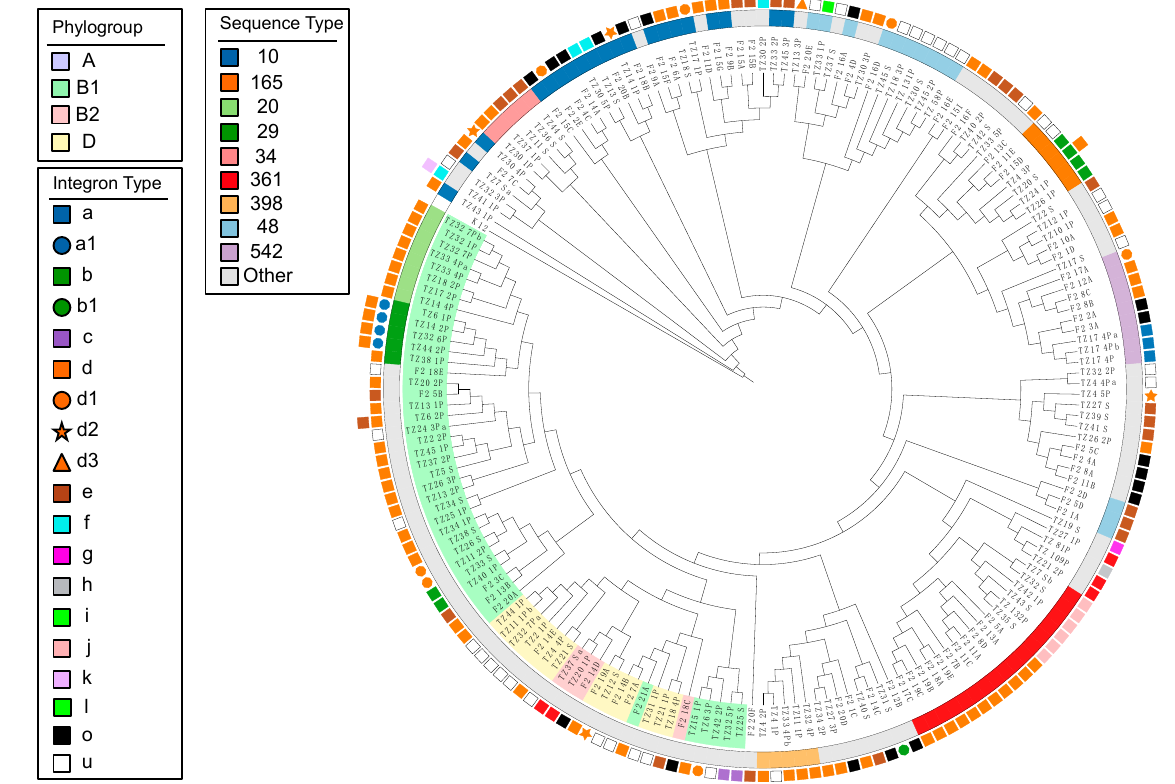
Figure 1. Maximum likelihood phylogeny shown as cladogram. The cladogram shows the 117 porcine commensal E. coli genomes from the present study as well as 68 from the second farm described in our previous study (labelled “F2”). Label highlight colour indicates phylogroups. Sequence types are represented by a coloured strip. Class 1 integron structures in Figure 3 are annotated with letters (a- l). “o” (black square) indicates that another integron not shown in Figure 3 was identified. “u” (white square) indicates that the integron structure was not determined.